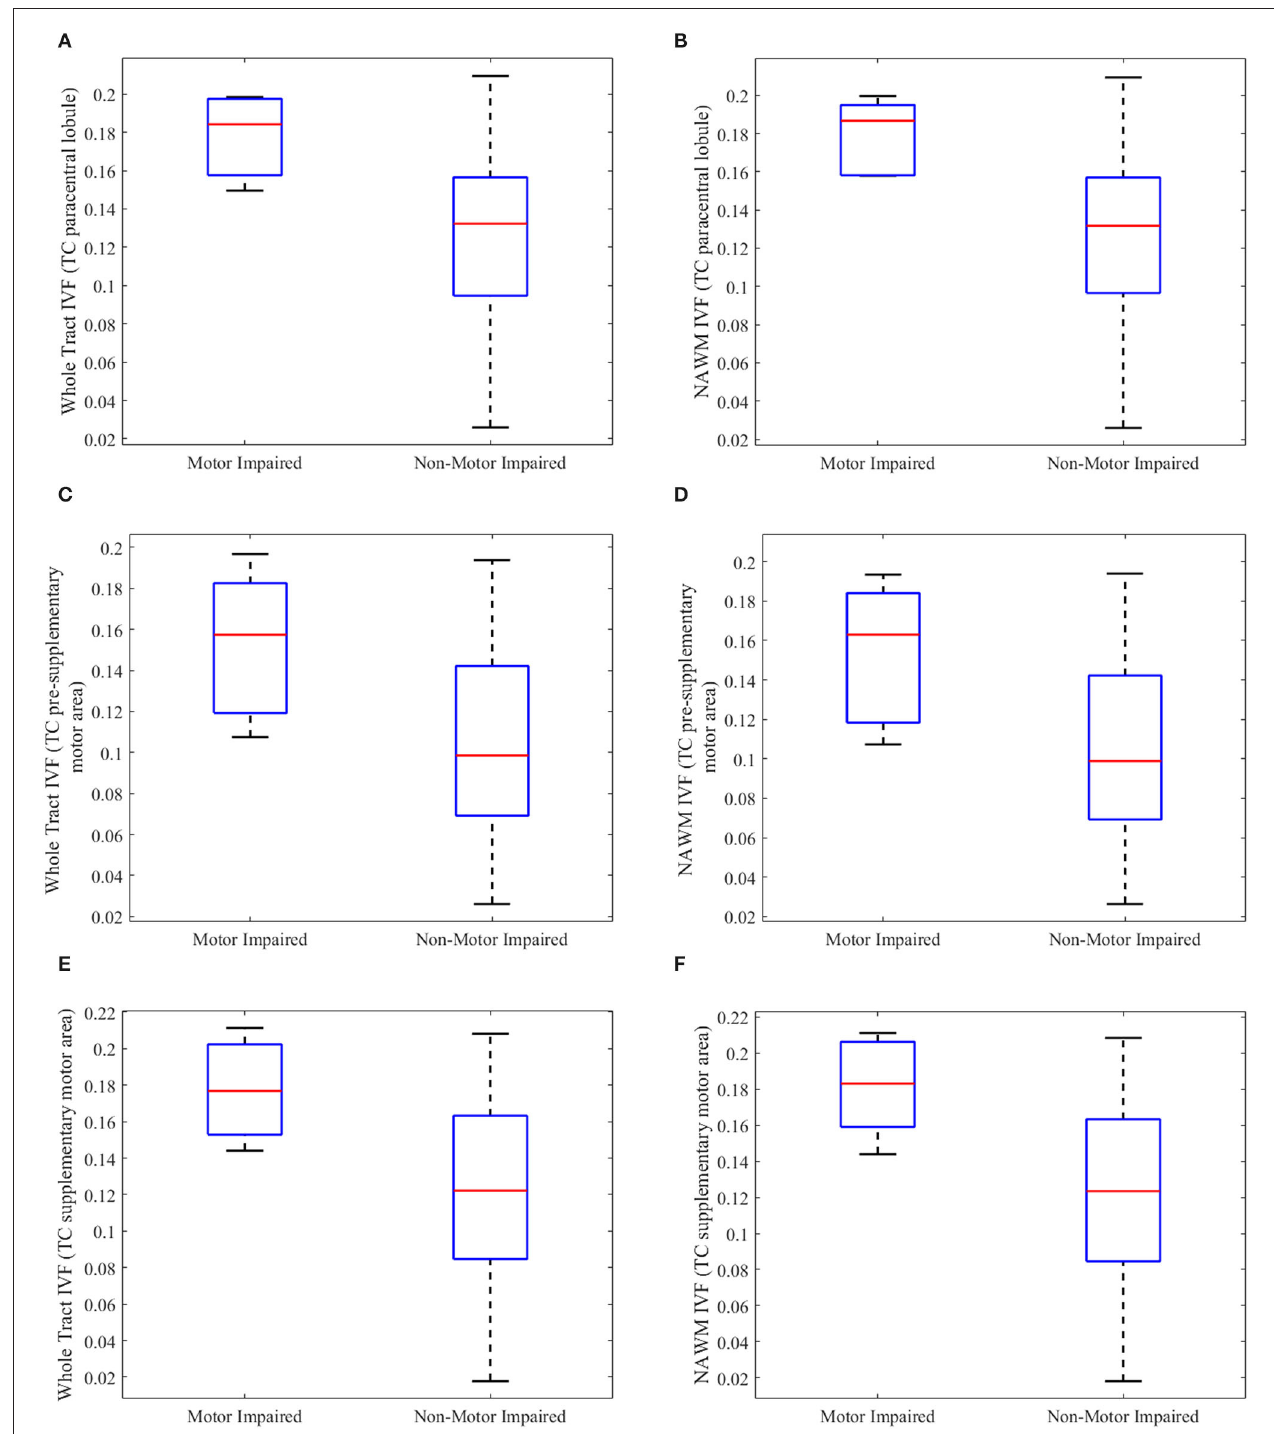
FIGURE 4 | Boxplots of tract metrics which were significantly different between person with multiple sclerosis with and without motor impairment. The isotropic volume fraction (IVF) values measured in the whole tract and normal appearing white matter (NAWM) of the transcallosal (TC) paracentral lobule (A,B) , TC presupplementary area (C,D) , and TC supplementary motor area tracts (E,F) in person with multiple sclerosis (pwMS) and motor impairment and those without motor impairment. (A,C,E) show whole-tract IVF values, while (B,D,F) show normal appearing white matter (NAWM) IVF values. The upper and lower black horizontal bars represent maximum and minimum values, respectively. The upper and lower blue horizontal bars represent the upper and lower quartiles, while the red bar represents the median of the group.